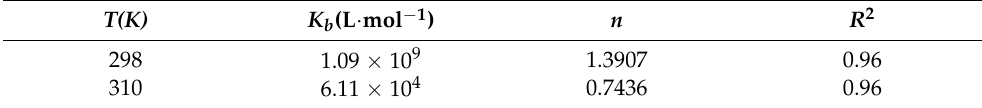
Table 2. K b and n values of different TDD and Cav1 protein at 298 K and 310 K.